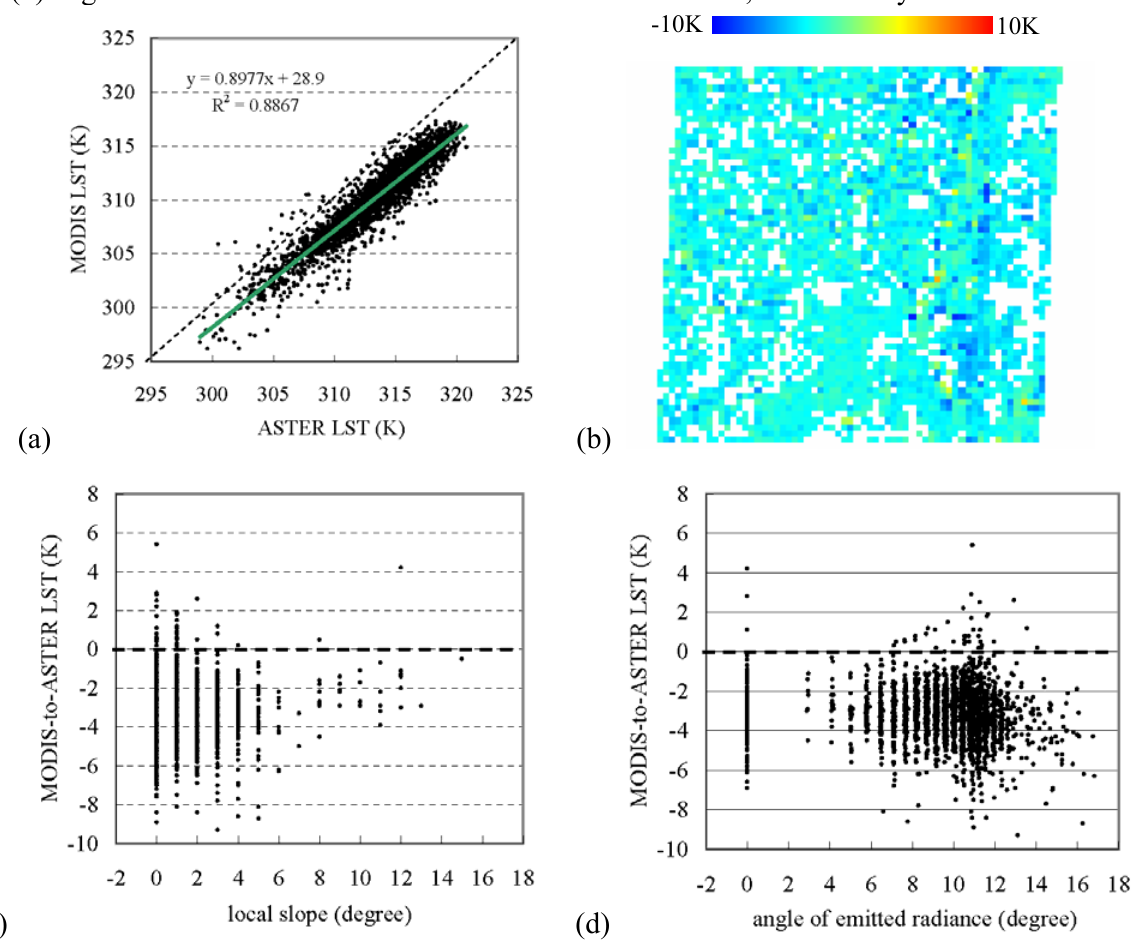
Figure 3 . (a) ASTER LST versus original MODIS LST, (b) spatial distribution of the ASTER-to-MODIS LST discrepancy, (c) local slope versus ASTER-to-MODIS LST, and (d) angle of emitted radiance versus ASTER-to-MODIS LST, for the study